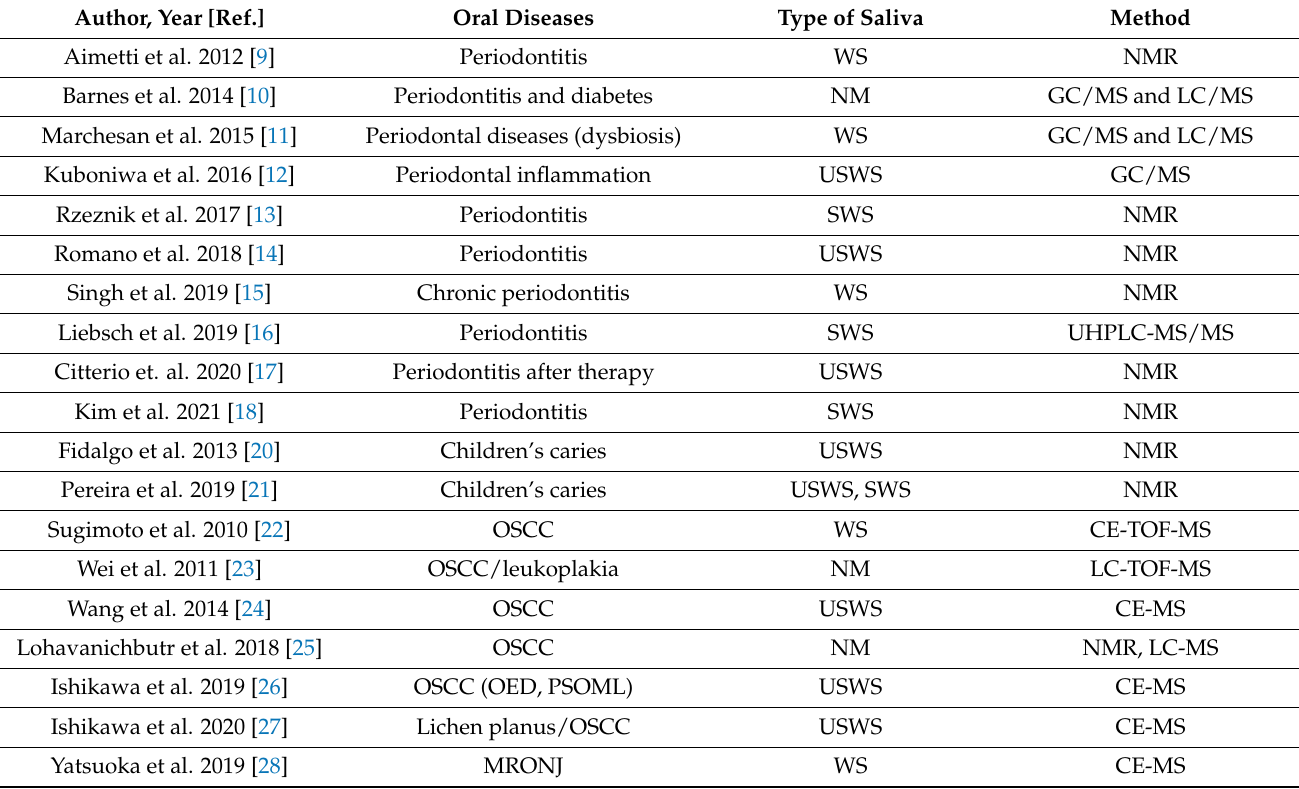
Table 1. Recent salivary metabolomic studies of oral